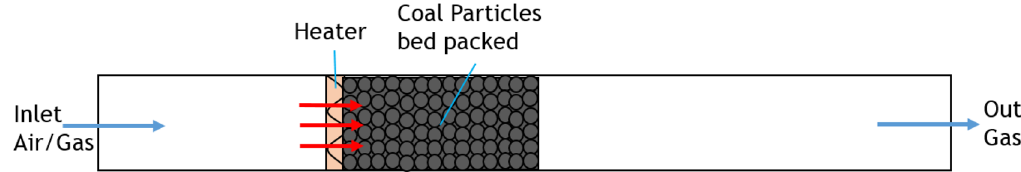
Fig. 1 Illustration of coal particle bed packed in a reactor